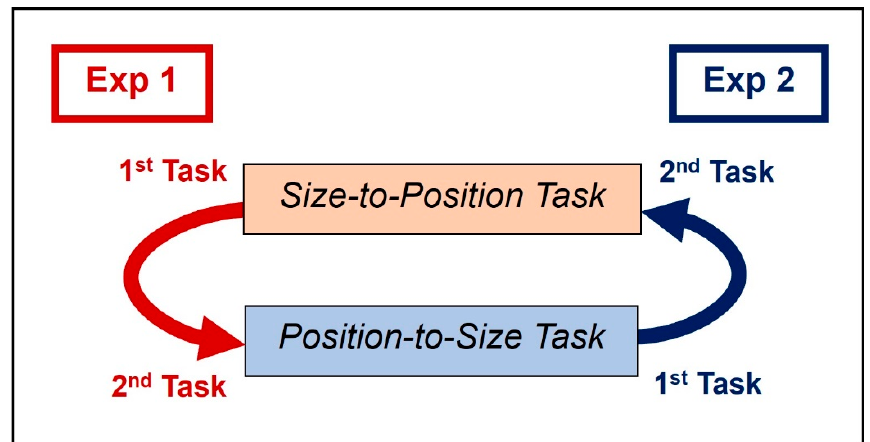
Figure 5. Task orders for Exp 1 and 2. The participants in Exp 1 performed the Position-to-Size task first (1st task) and then the Size-to-Position task (2nd task); and in Exp 2, they performed the Size-to-Position task first (1st task) and then the Position-to-Size task (2nd task). The results from the 1st task (target positions from the Size-to-Position task, and target sizes from the Position-to-Size task) were used in the 2nd task.